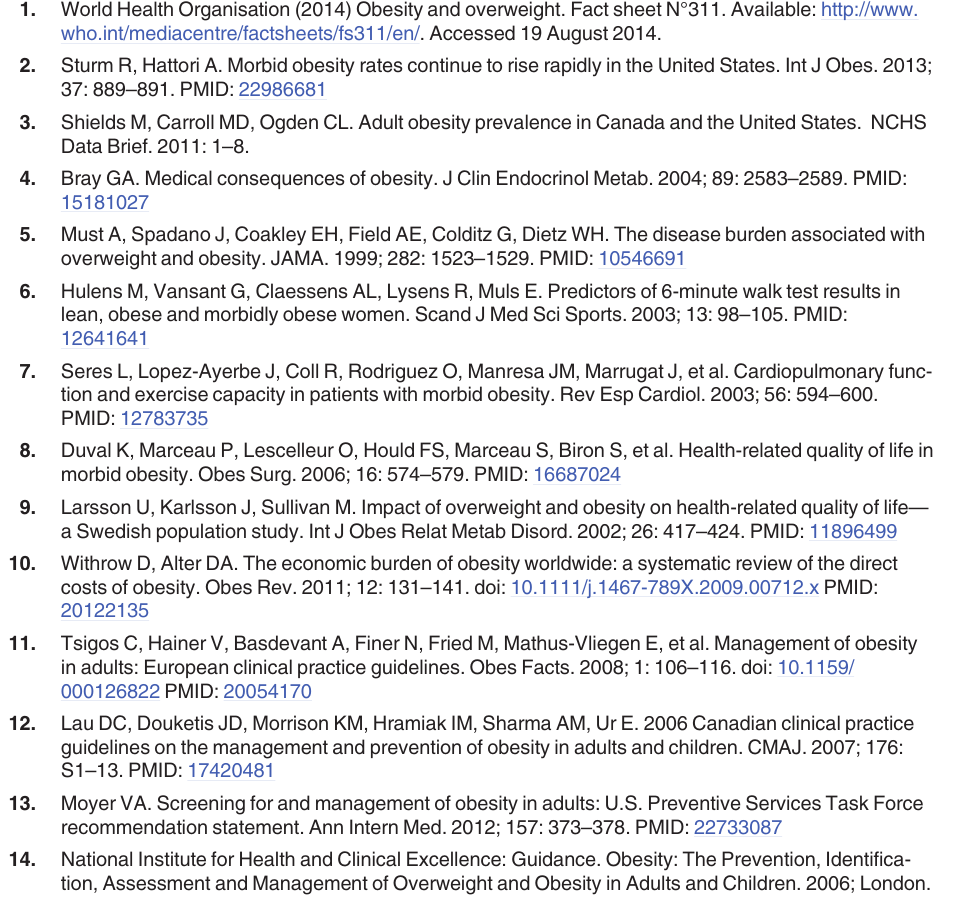
S4 Fig. Regression plot of mean difference on weight loss (kg) with studies length as inde- pendent variable in class II and III obese individuals. Note: Each circle represents an